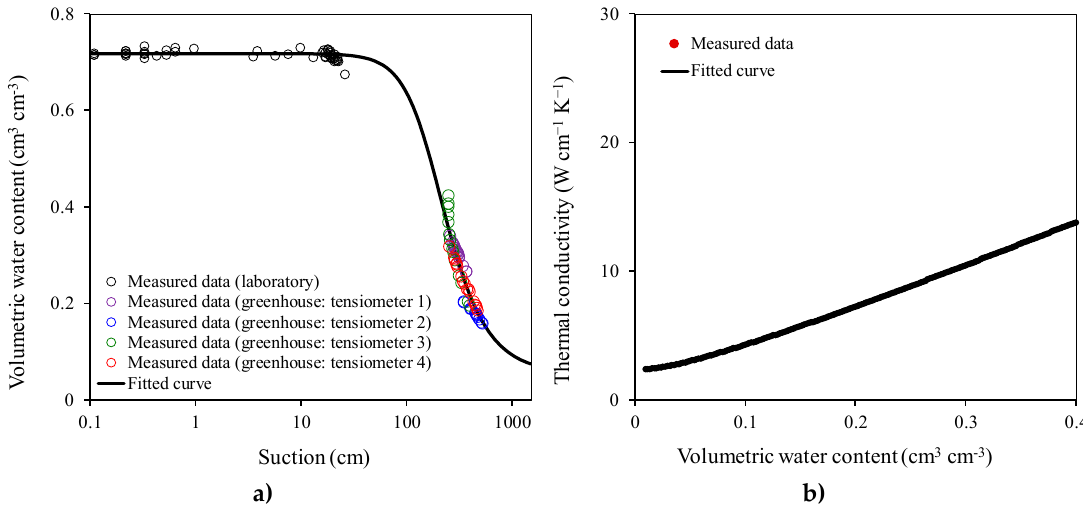
Figure 2. ( a ) Soil water characteristics curve of the culture substrate (Sunshine ® #5 Natural & Organic Mix) during the drainage stage; ( b ) Relationship between thermal conductivity and volumetric water content of the culture substrate.